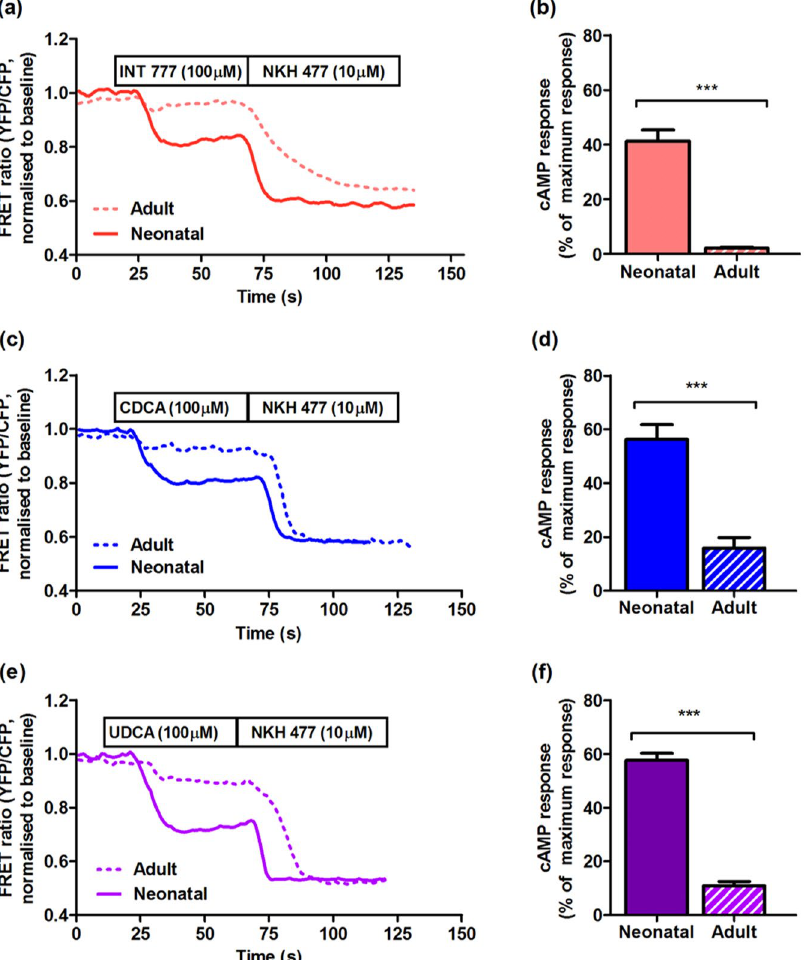
Figure 4. Adult cardiomyocytes show less cAMP response for bile acids compared to neonatal. Representative traces of FRET in neonatal and adult mouse cardiomyocytes of cEpac1-camps transgenic mice treated with ( a ) INT777, ( c ) CDCA, ( e ) UDCA at 100 μ M; Normalised cAMP responses of neonatal and adult cardiomyocytes following stimulation of ( b ) INT777, ( d ) CDCA, ( f ) UDCA at 100 μ M (n = 6, * p < 0.05, ** p <